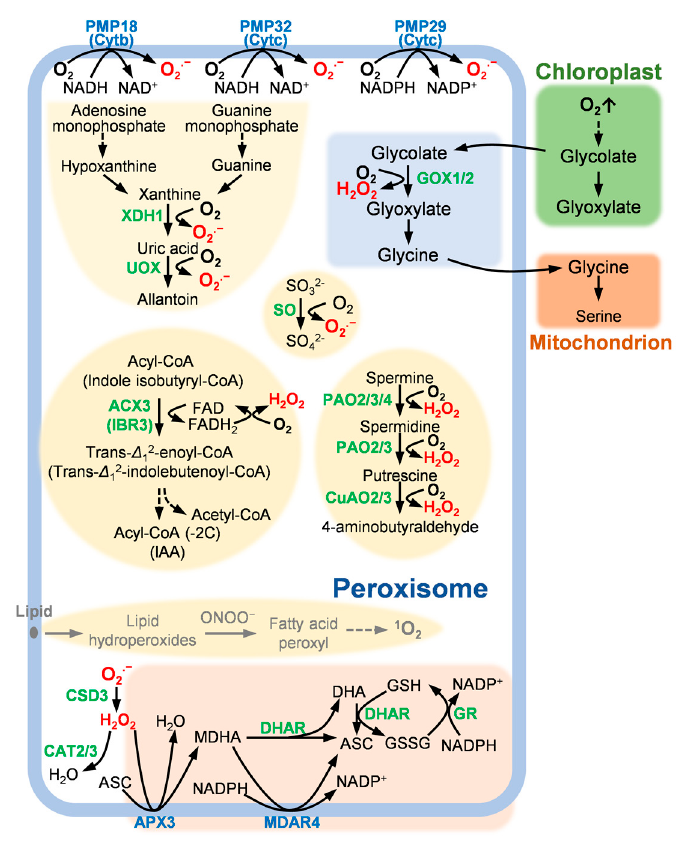
Figure 1. ROS modulation mechanism in peroxisome. PMP, peroxisomal membrane polypeptide; XDH1, xanthine dehydrogenase 1; UOX, urate oxidase; SO, sulfite oxidase; ACX3, acyl-CoA oxidase 3; IBR3, indole-3-butyric acid-response 3; CSD3, copper/zinc superoxide dismutase 3; CAT, catalase; APX3, ascorbate peroxidase 3; MDAR4, monodehydroascorbate reductase 4 (also known as